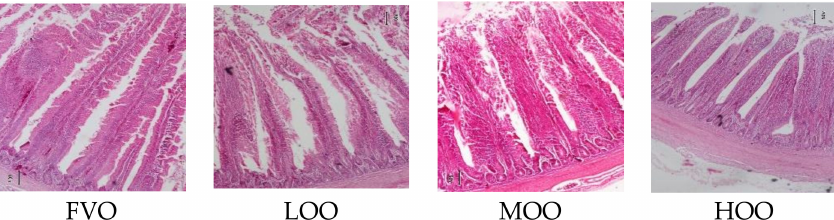
Figure 1. Duodenal villus height morphological representation of broilers fed various levels of